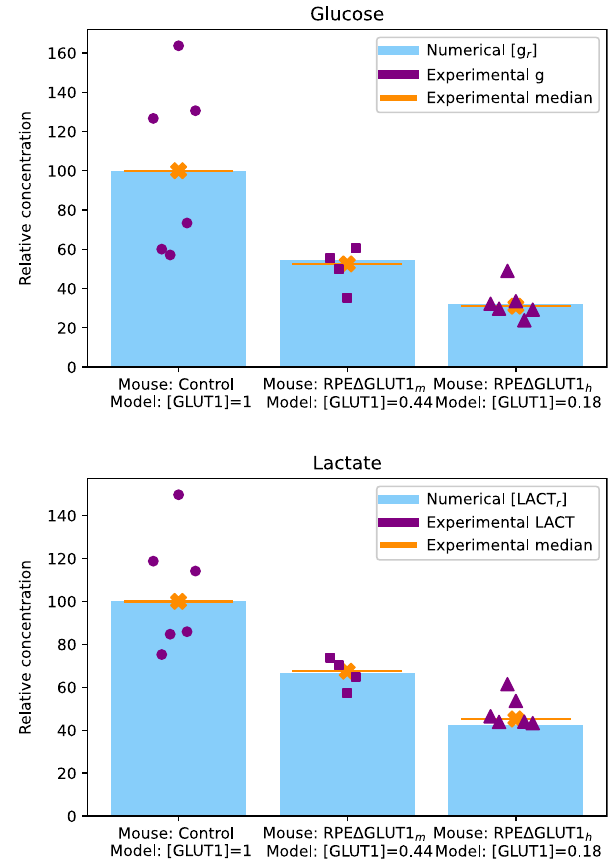
Figure 6. The relative metabolite concentrations obtained from running numerical simulations of system (1)– (11) match the experimental results of 28 . We iteratively ran our model with the parameters in Table 1 except for [GLUT1], which was changed by a small fraction every time. For each simulation we let our system run until all the metabolites had reached a steady state, and recorded the concentration values of glucose ([g r ]) and lactate ([LACT r ]) in the rods. We then calculated the relative concentrations of both metabolites with respect to the case when [GLUT1] = 1, i.e., we gave the control case a value of 100 and scaled the rest accordingly. Then, we looked for the [GLUT1] values for which the steady state most closely matched the data obtained in Swarup et al. 28 for the metabolite intensity of RPE (cid:31) GLUT1 m , and RPE (cid:31) GLUT1 h mice (expressing approximately 50% and less than 30% of the control GLUT1 concentration, respectively). The purple circles, squares and triangles mark the relative intensities of lactate and glucose in the the control, RPE (cid:31) GLUT1 m , and RPE (cid:31) GLUT1 h mice, respectively, and the orange lines are the medians. Blue bars mark the numerical relative concentrations of [g r ] and [LACT r ] when [GLUT1] = 1 (left), [GLUT1] = 0.44 (center) and [GLUT1] = 0.18 (right), which are the closest match to the medians of the experimental data, and match the approximate GLUT1 expression in the mice. We found that the scaling of our numerical results match the corresponding scaled experimental